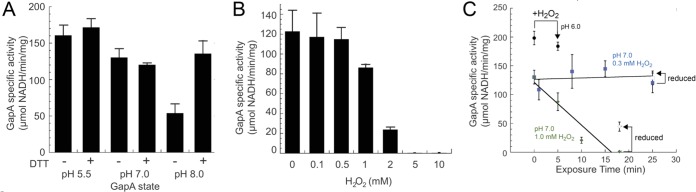
S. pneumoniae GapA is sensitive to oxygen and H2O2 exposure. (A) Specific activity of recombinant S. pneumoniae GapA at various pHs. (B) Specific activity of recombinant S. pneumoniae GapA after incubation with H2O2 (0 to 10 mM) at pH 7.0. (C) Specific activity of S. pneumoniae GapA highlighting the role of pH and H2O2 concentration. S. pneumoniae GapA is resistant to H2O2 at pH 6.0 (black circles). In the blue squares, the time-dependent inactivation of recombinant S. pneumoniae GapA is shown in the presence 0.3 mM H2O2 at pH 7.0. Green diamonds show time-dependent inactivation of recombinant S. pneumoniae GapA at pH 7.0 in the presence of 1 mM H2O2. Open symbols show the specific activity of S. pneumoniae GapA after incubation with DTT (50 mM).